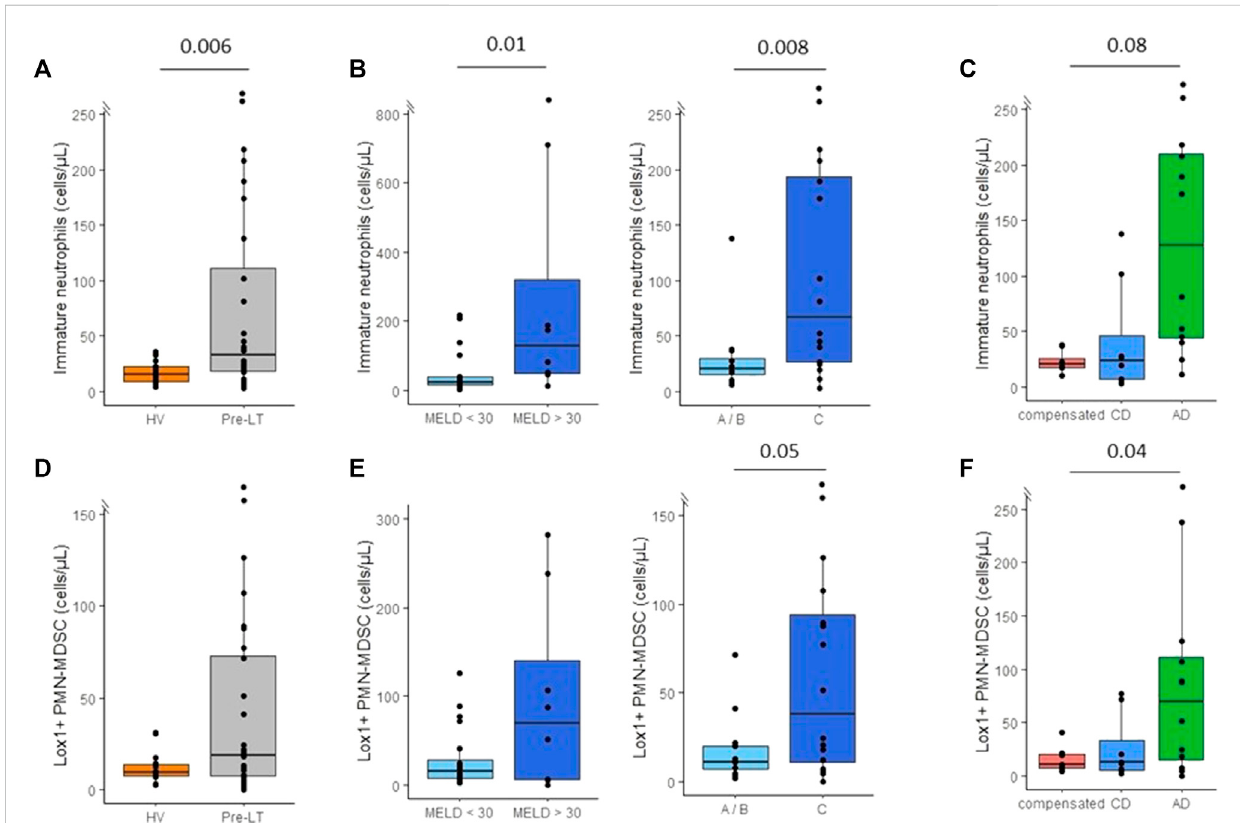
FIGURE 3 Monitoring of immatures neutrophils (CD16 low ) and lectine-type oxidized LDL receptor 1 polymorphonuclear myeloid-derived suppressor cells (LOX1+ PMN-MDSC) in peripheral blood of pre-transplant patients. (A) Immature neutrophils count in healthy volunteers (HV, n = 15) and pre-transplant patients(pre-LT, n =28). (B) ImmatureneutrophilscountinpatientswithaMELDscore < 30( n =20)orwithaMELDscore ≥ 30( n =8)andinpatientswith Child-Pugh score A or B (A/B, n=12) or with Child-Pugh score C (n=16). (C) Immature neutrophilscountin patients with compensated cirrhosis ( n = 8),chronicdecompensatedcirrhosis(CD, n =8)andacutedecompensatedcirrhosis(AD,with n =10orwithoutACLF n =2). (D) NumberofLOX1+MDSC in healthy volunteers (HV) and pre-transplant patients (pre-LT). (E) Number of LOX1+ MDSC in patients with or without MELD score < 30 and in patients with Child-Pugh A/Bor C. (F) Number ofLOX1+ MDSC inpatients with compensated,chronic decompensated, andacute decompensated cirrhosis. The nonparametricWilcoxon testwasused to assessdifferencesbetweenpatientsand HVand between patients ’ subgroups determined byMELD and Child- Pugh score. Kruskal-Wallis test was used to assess differences between more than 2 independent